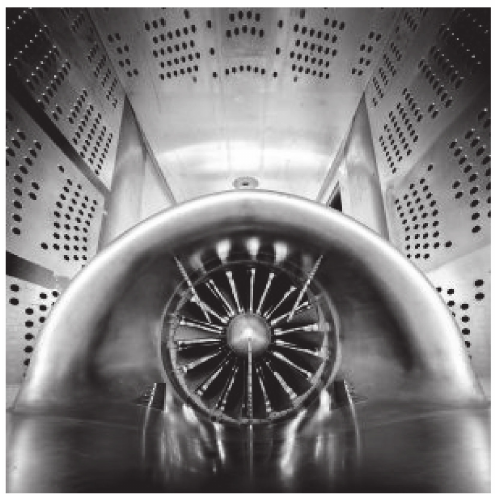
Figure 3. High-speed testing of the distortion tolerant fan propulsor at the NASA Glenn Research Center 8 (cid:48) × 6 (cid:48) wind tunnel